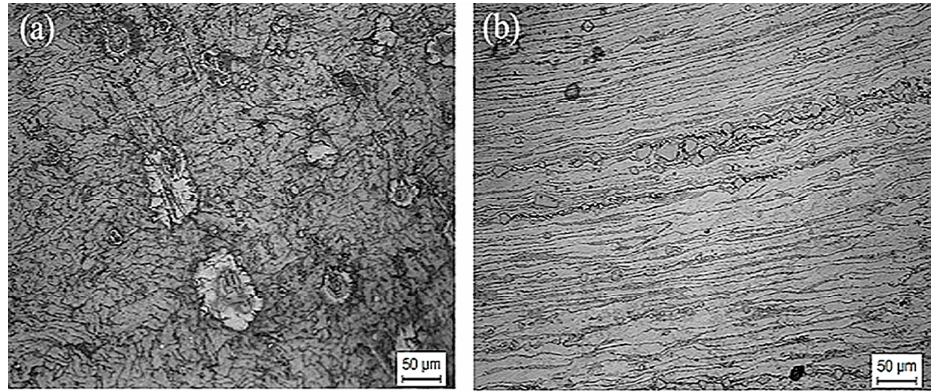
Figure 7. Processing maps of NiTiNb SMA based on various strains: ( a ) ε = 0.3; ( b ) ε = 0.6; and ( c ) ε = 0.9. The blue color in the figure represents the instability region.